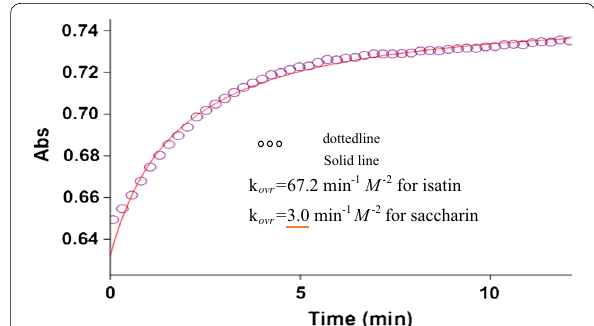
Fig. 9 The original experimental absorbance curve versus time at a selected wavelength of 305 nm for the reaction between (1) (10 − 2 M), ( 2 ) (5 10 − 3 M) and isatin ( N – H ) (10 − 2 M) in methanol. The × dotted curve shows experimental values, and the solid line is the fitted curve at 18